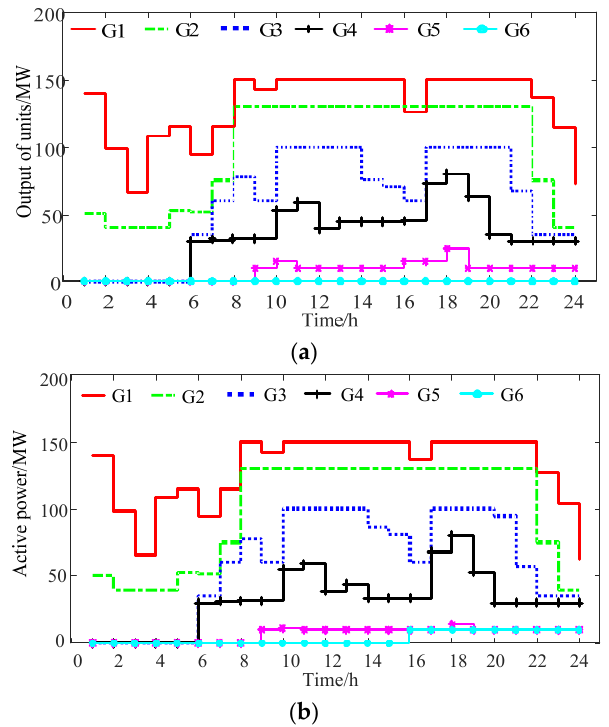
Figure 8. Power output of units in different dispatch modes: ( a ) Separate optimization and ( b ) coordinated optimization.